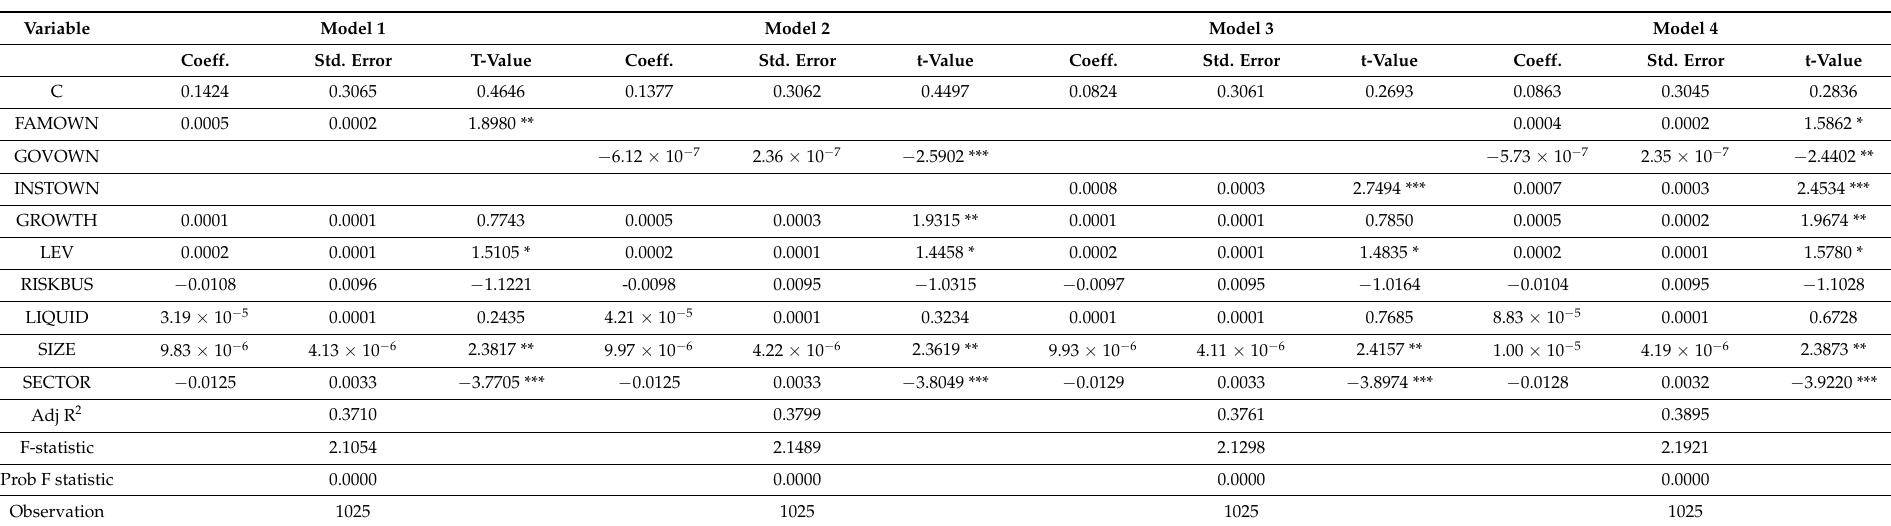
Table 5. Regression